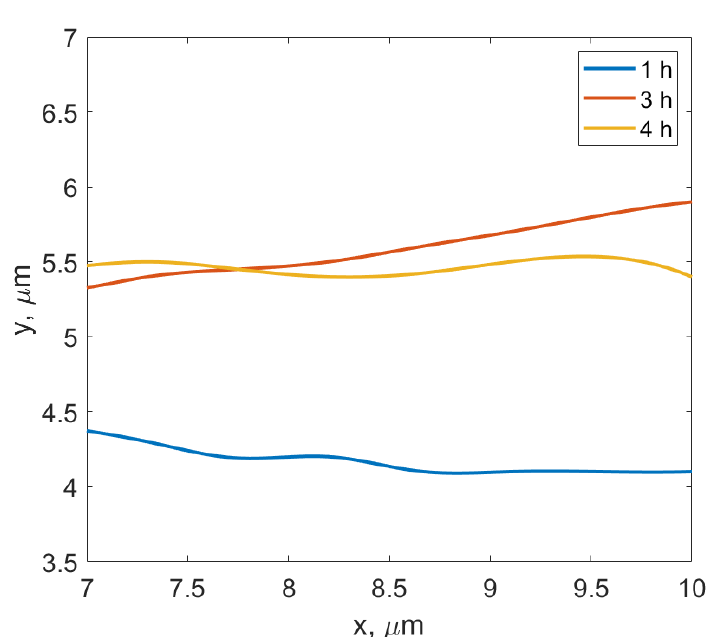
Figure 9. Trace of the grain boundary after 1, 3, and 4 h for SL 2 .